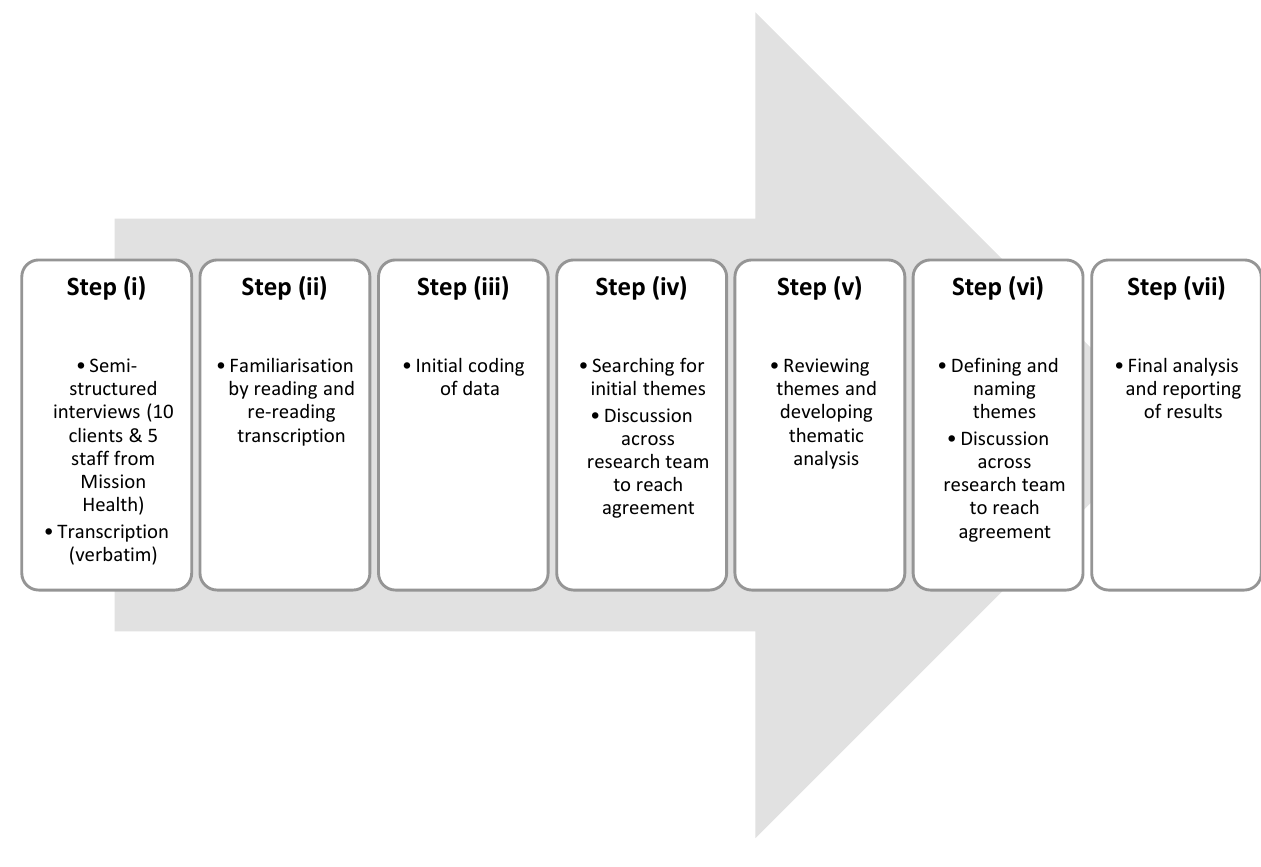
Figure 1. Overview of the analysis process.